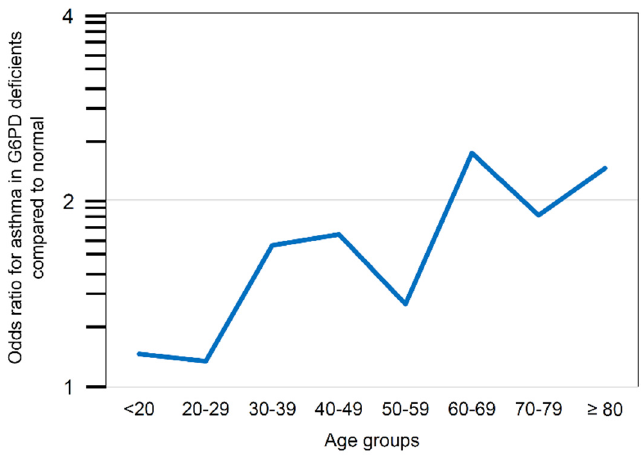
Figure 2. Asthma risk in G6PD-deficient patients compared to non-deficient patients according to age decades.